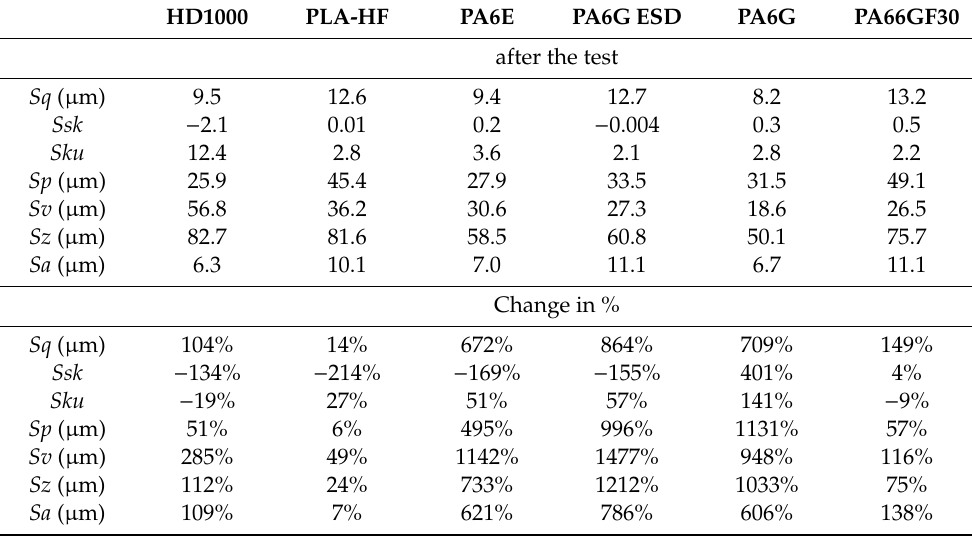
Table 8. Surface characteristics after the tests and the change in